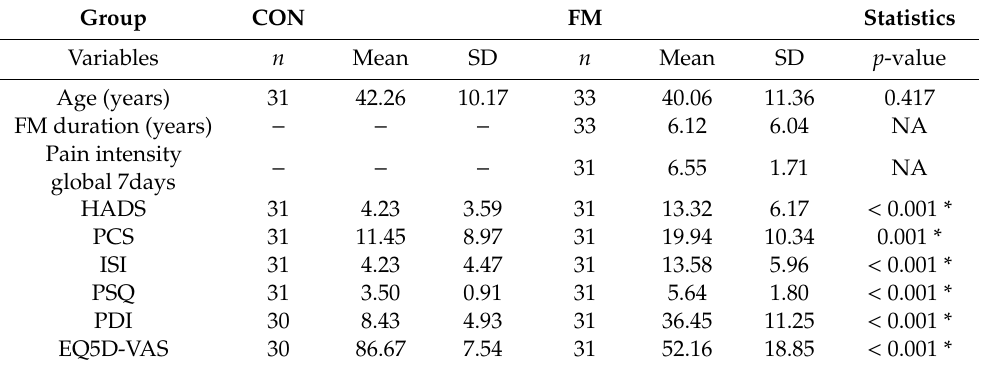
Table 1. Data obtained from questionnaires in controls and in patients with fibromyalgia (FM). Group CON